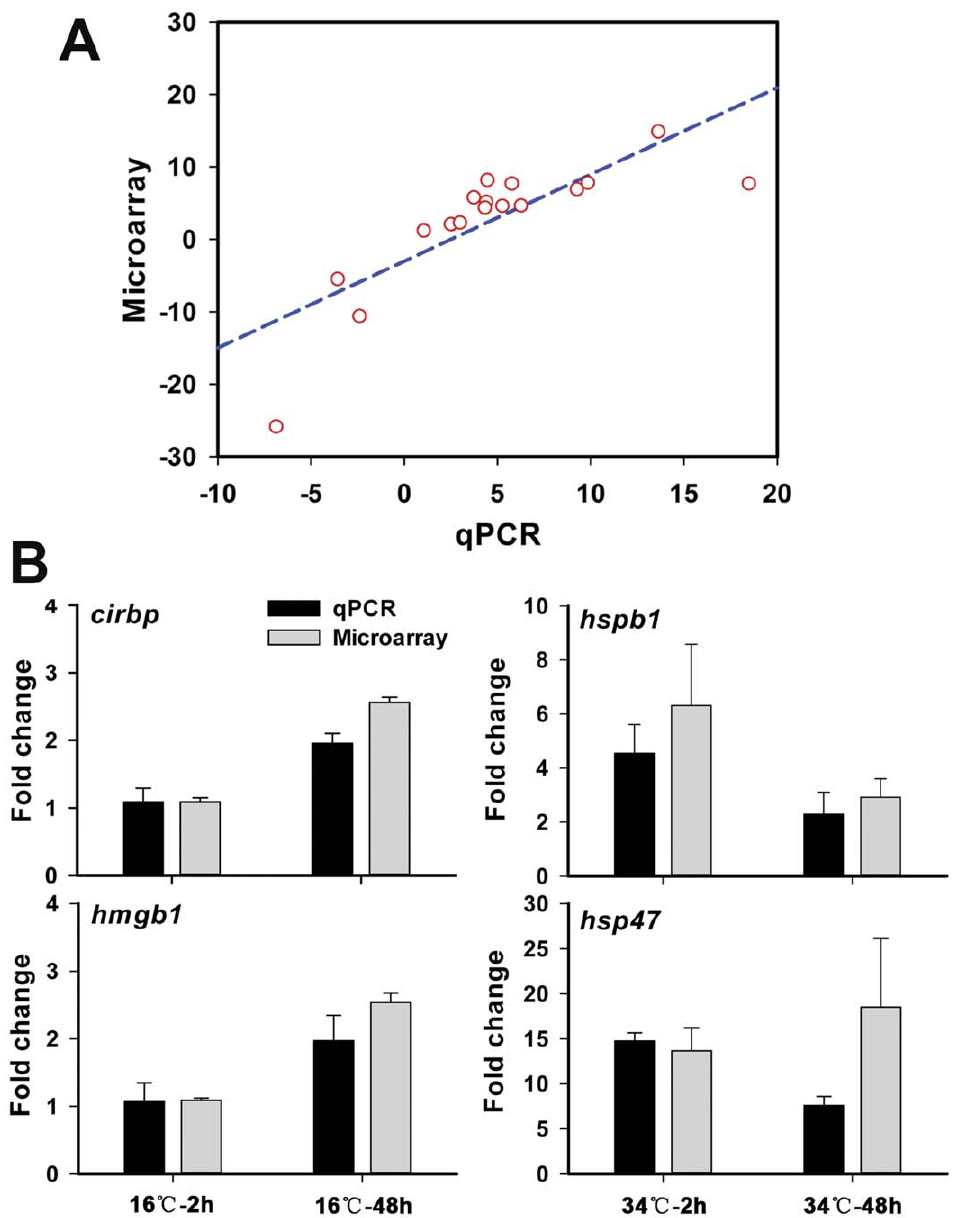
Figure 4. Validation of microarray data by qPCR. ( A ) Correlation between qPCR (x-axis) and microarray (y-axis) data. The numeric expression values of genes in selected samples were displayed in Table S3. The correlation between microarray and qPCR data were analyzed by Spearman’s rho test. Highly statistical significance [r (17)=0.916, p=0.00001] was observed. ( B ) Pair wise comparison of microarray and qPCR data for temperature stress-related marker genes. The expression of cirbp and hmgb1 was detected in cold-treated samples (16 u C-2 h and 16 u C-48 h), and the expression of hspb1 and hsp47 were detected in heat-treated samples (34 u C-2 h and 34 u C-48 h), respectively. Error bars indicate standard deviations (n =3).